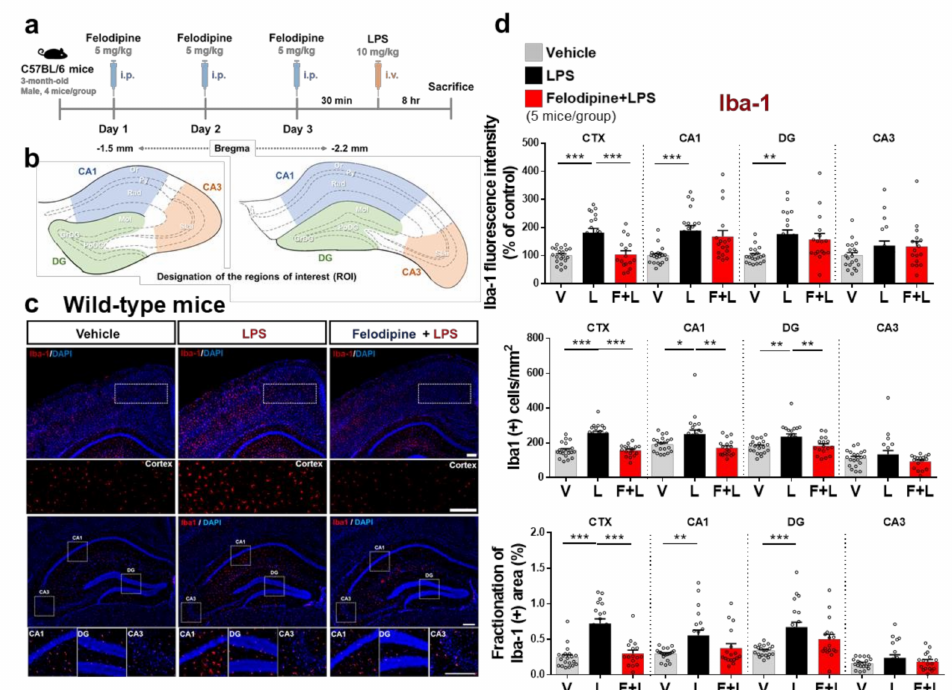
Figure 4. Daily administration of felodipine for 3 days decreases LPS-induced microgliosis in the cortex and hippocampus of C57BL/6 mice. ( a ) Experimental scheme of felodipine treatment in vivo. ( b ) Coordinates and specific locations of the hippocampus used for immunofluorescence staining. ( c ) C57BL/6 mice were injected with vehicle (5% Tween20 + 5% PEG300 in saline) or felodipine (5 mg/kg, i.p.) daily for 3 days. On day 3, LPS (10 mg/kg, i.v.) or PBS was injected, and immunoflu- orescence staining was conducted with an anti-Iba-1 antibody. ( d ) Quantification of data from ( c ) (n = 5 mice/group. Vehicle, n = 20 brain slices; LPS, n = 20 brain slices; felodipine+LPS, n = 16 brain slices. * p < 0.05, ** p < 0.01, *** p < 0.001, scale bar = 100 µ M. V: vehicle; L: LPS; F or Felodi: